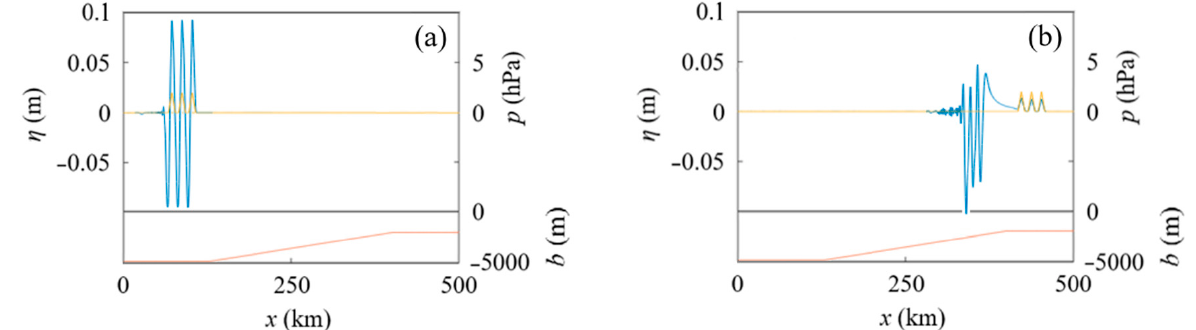
Figure 11. Water surface profiles in Case I, where x 1 = 55 km and δ = 5 km in Figure 1; h on = 2000 m, x slope = 120 km, x on = 400 km, and the slope gradient β = 1.07 × 10 − 2 in Figure 2b. The blue, orange, and red lines indicate the water surface displacement η , atmospheric pressure p , and seabed position b , respectively. ( a ) t = 210 s. ( b ) t = 1610 s.